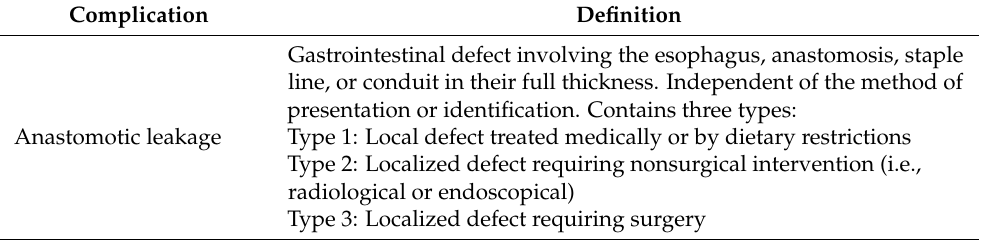
Table 2. ECCG complication definitions